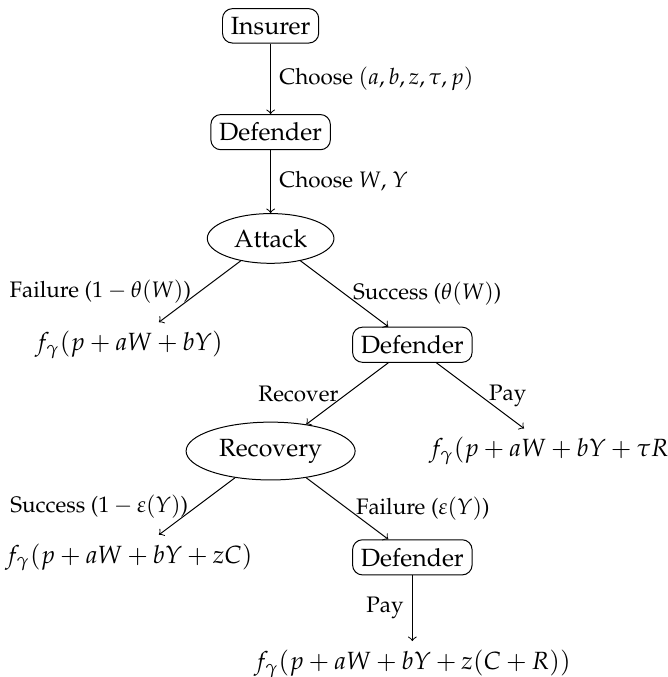
Figure 2. The Defender-Insurer (D-I) game tree, with the corresponding utility of the defender U in under each possible game outcome. Rounded corners indicate the player whose turn it is to move; ovals indicate stochastic events (with probabilities written next to each outcome). The argument in f γ () is the defender’s total cost, whose expression changes depending on the different realizations of the game. The defender’s actions are not in response to the insurer but rather to the attack; while these actions are not part of the D-I game, they must be anticipated in order to compute ( W , Y )